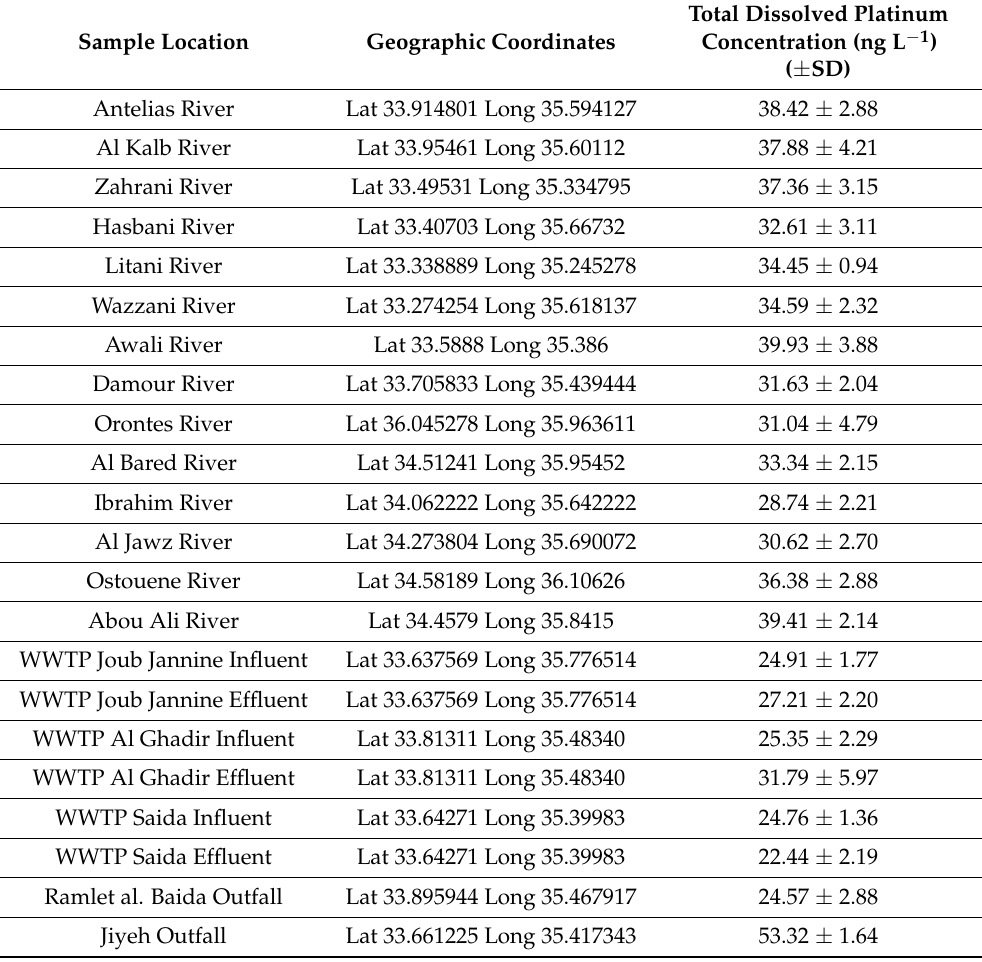
Table 5. Concentrations of total platinum in Lebanese water samples in ng L − 1 ( ± SD of the concen- trations